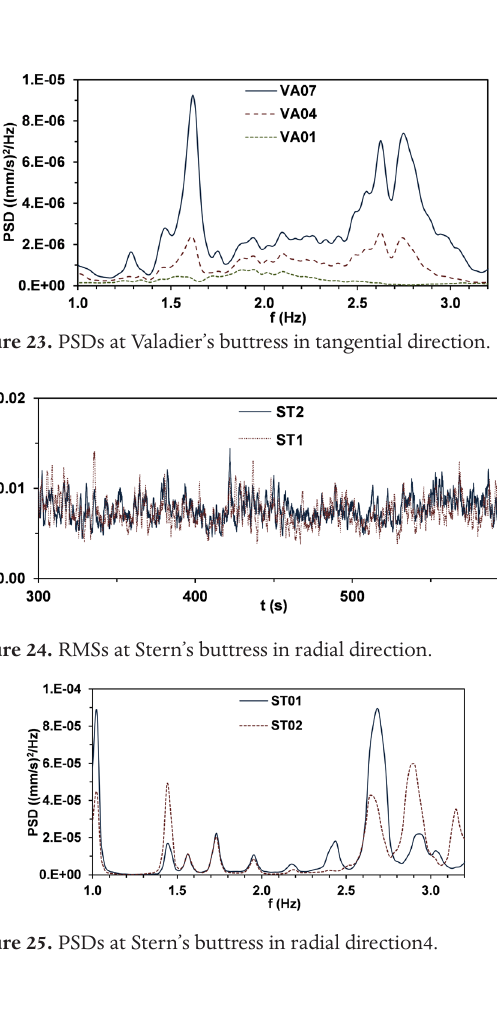
Figure 19. Plan view of the seismometer locations in the second